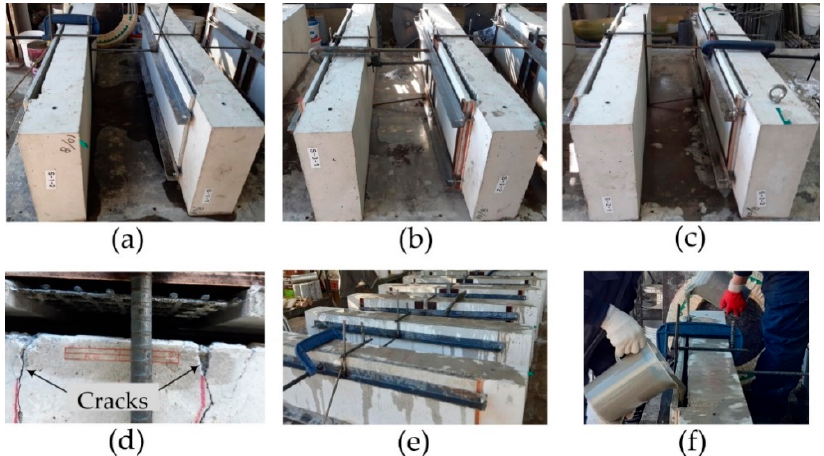
Figure 20. Re-strengthening process of the damaged slabs: ( a ) series RS-1; ( b ) series RS-2; ( c ) series RS-3; ( d ) lap splice joint; ( e ) water spraying; and ( f ) grouting.